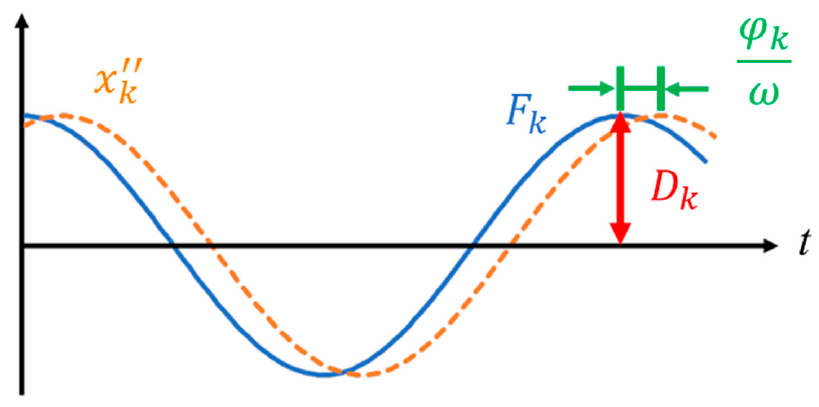
Figure 7. Schematic of phase difference between force and acceleration.